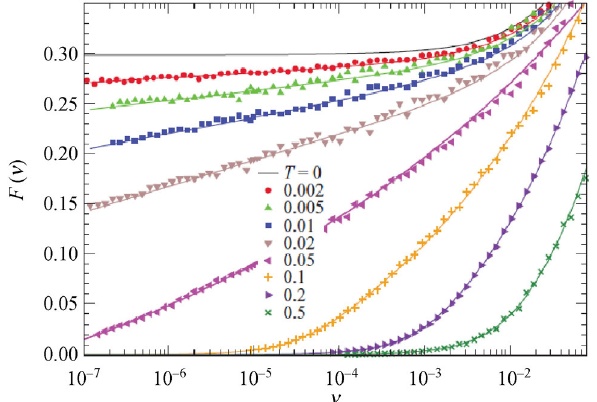
Fig. 10 Variation of kinetic friction with sliding velocity and tem- perature predicted from a molecular dynamics model. Reproduced with permission from [101]. Copyright AIP,